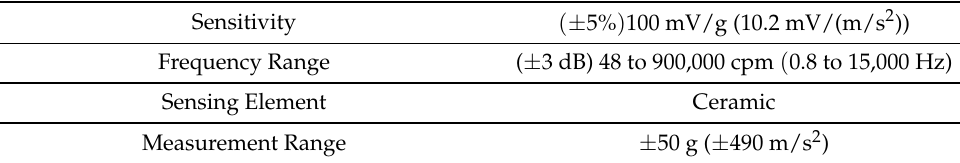
Table 1. The Piezo-accelerometer IMI 623C01 specification